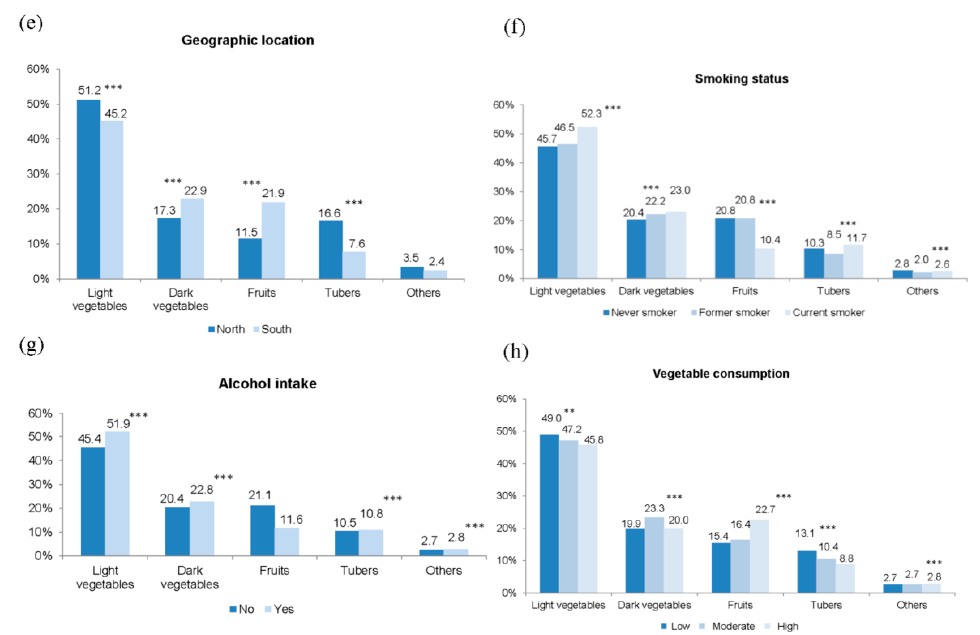
Figure 1. Contribution percentage of food sources to the total vitamin C intake by sociodemographic factors. ( a ) Total subjects; ( b ) subgroups by gender; ( c ) educational level; ( d ) residence area; ( e ) geographic location; ( f ) smoking status; ( g ) alcohol intake; ( h ) vegetable consumption. ** p < 0.01, and *** p < 0.001 indicate significant differences in the distribution of the contribution percentages of food sources to the total vitamin C intake by sociodemographic factors by Wilcoxon rank-sum test or Kruskal-Wallis